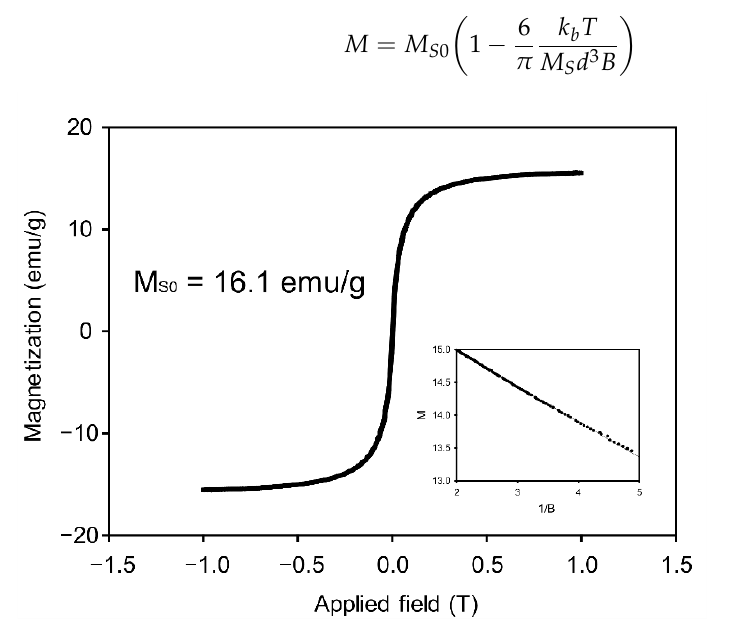
Figure 2. Magnetization value of magnetic hydrogel particles according to the intensities of an applied magnetic field. The inset is a linearized graph using the reciprocal of the magnetic field as the x -axis.